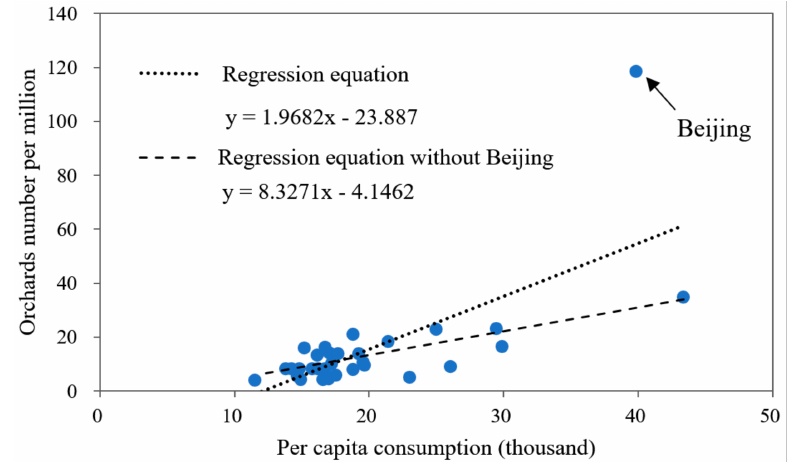
Figure 7. The correlation analysis between economic factors and picking orchards (the higher the consumption expenditure is, the more picking orchards per capita there